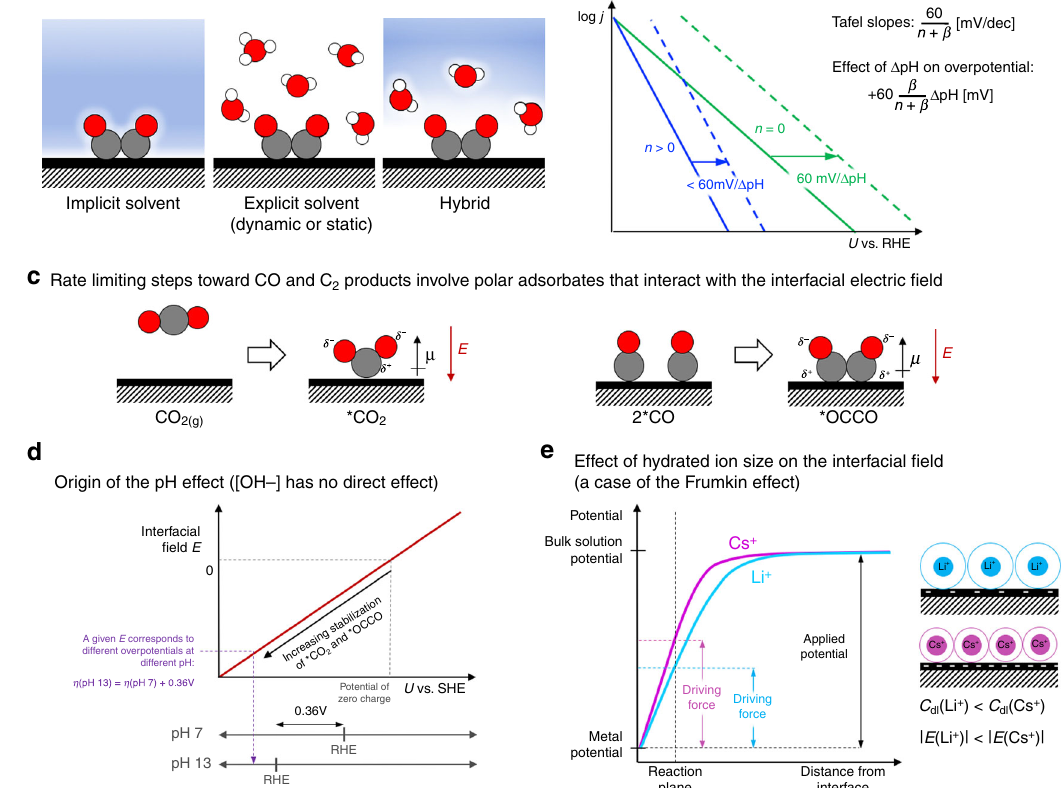
Fig. 1 Some basic ideas from mechanistic studies of electrochemical carbon dioxide reduction. a Implicit, explicit, and hybrid approaches to model the electrolyte in ab initio simulations. b In electrochemical reactions with multiple proton – electron transfers, the number of electrons n transferred prior to the rate-limiting step determines both the Tafel slope and how changes in pH shift the activity. c Rate-limiting steps for CO 2 reduction to CO (on weak binding catalysts) and C 2 products (on Cu) involve intermediates with large dipole moments μ , which interact with the interfacial electric fi eld E . d The absolute potential (e.g., U vs. SHE) determines the electric fi eld at an electrochemical interface and the corresponding stabilization of the polar *CO 2 and *OCCO intermediates. Since the dipoles point away from the interface, the fi eld-stabilization occurs at potentials below the potential of zero charge. A given fi eld stabilization corresponds to a more positive overpotential at higher pH (e.g., a 360 mV shift between pH 7 and 13), which leads to higher CO (2) R activity at higher pH. e The differences in hydrated cation sizes (e.g. hydrated Li + vs. hydrated Cs + ) lead to differences in the surface charge density and interfacial fi eld at a given applied potential. This model is an example of the Frumkin effect: the interfacial fi eld (or equivalently the local potential drop) is the driving force for electrochemical processes, and different compositions of the electric double layer give rise to different fi elds at a given applied